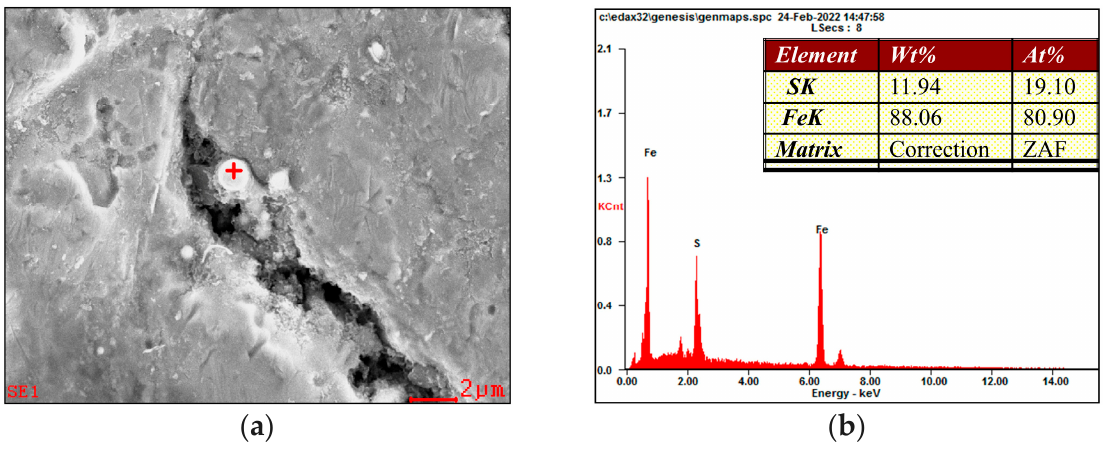
Figure 12. EDS analysis near the cracks: ( a ) SEM image; ( b ) element content (Test location as the red ‘+’ shown in Figure 12a).